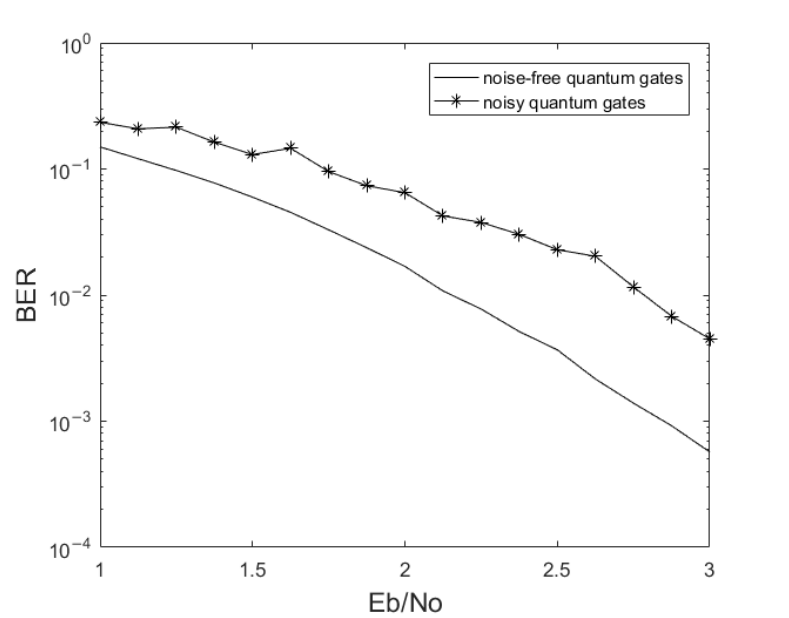
Figure 5. Simulation of the [6,2,2] quantum convolutional code with noisy quantum gates.